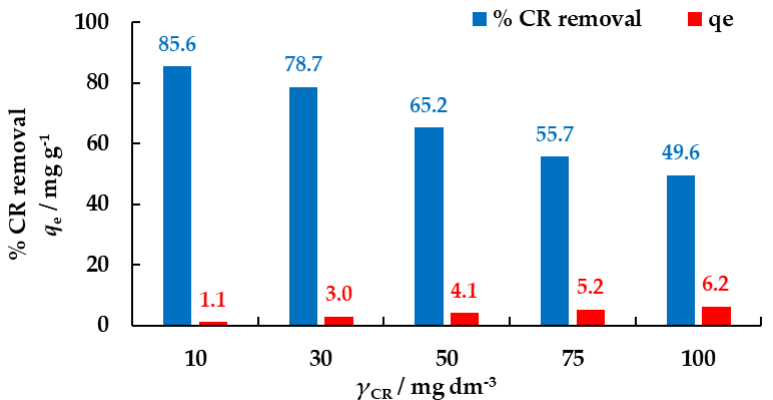
Figure 7. The effect of initial CR concentration on biosorption to EP ( γ biosorbent = 8 mg dm − 3 , t = 360 min, pH = 7, T = 298.15 K, v = 150 rpm).